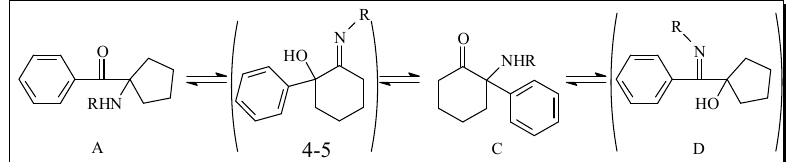
Figure 2. Hypothetical model (according to Stevens [18–26]) for inter-conversion between A, C and D by a thermal rearrangement.